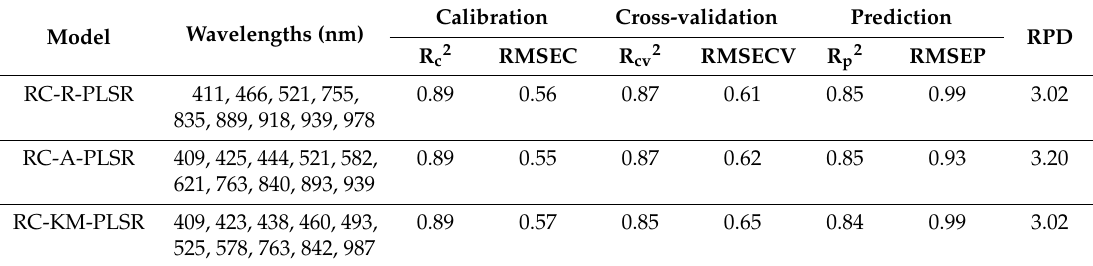
Table 2. Performance of multispectral PLSR models developed by wavelengths selected using three spectral